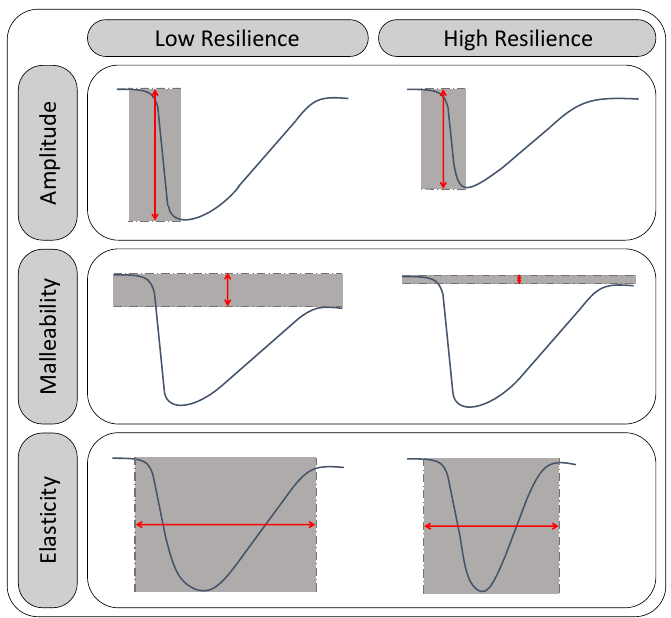
Figure 2. Interpretation of resilience status of an ecosystem from the resilience